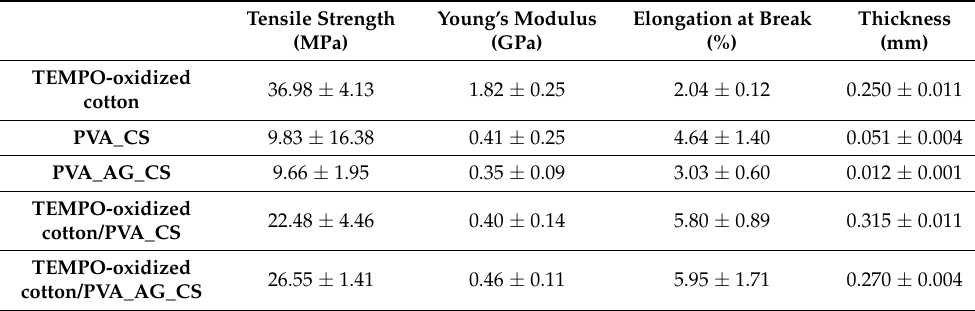
Table 1. Characterization of the mechanical properties of the produced dual-layer dressing material and associated raw materials. Tensile Strength Young’s Modulus Elongation at Break Thickness (MPa) (GPa) (%) (mm) TEMPO-oxidized 36.98 ± 4.13 1.82 ± 0.25 2.04 ± 0.12 0.250 ± 0.011 cotton PVA_CS 9.83 ±